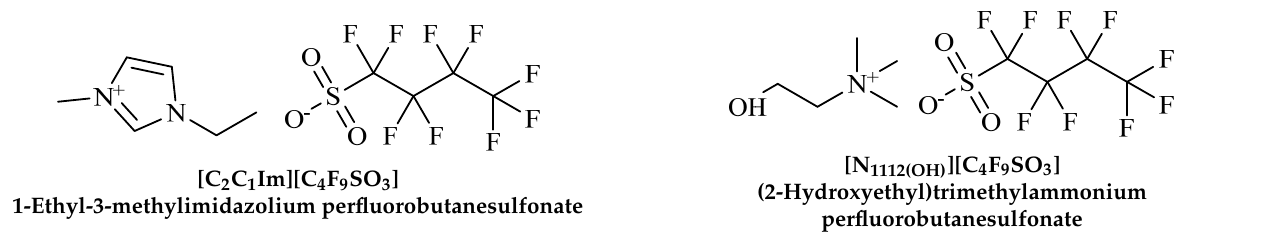
Table 1. The chemical structure and acronyms of the fluorinated ionic liquids studied in this work.